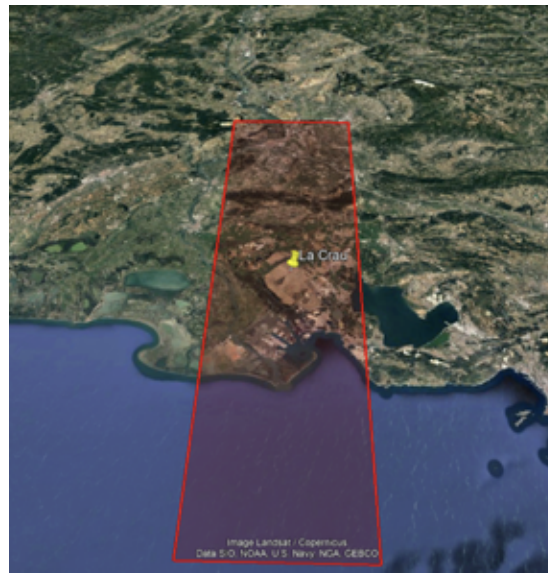
Figure 8. La Crau site with Hyperion image footprint.